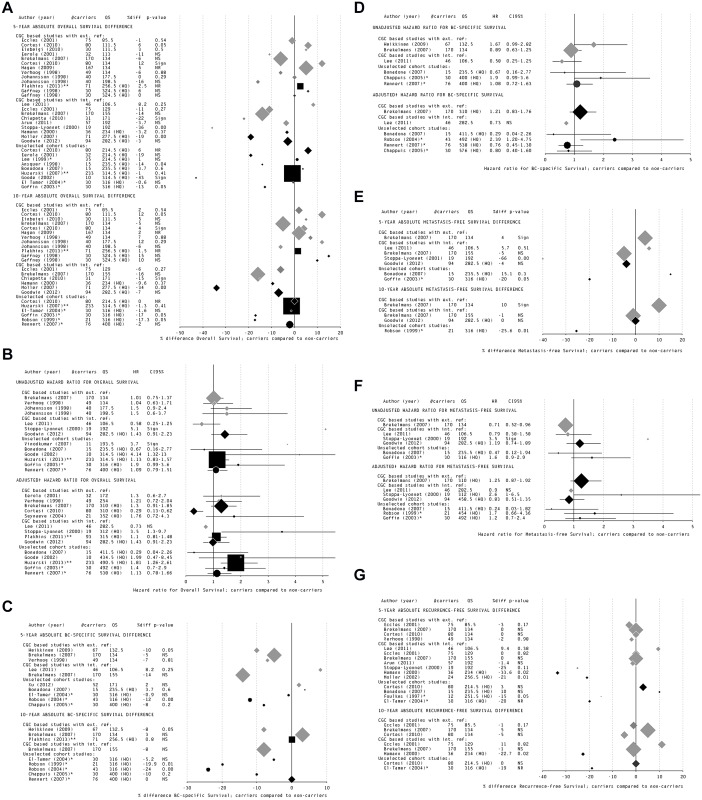
Forest plots of studies reporting survival estimates for BRCA1 mutation carriers compared to ‘non-carriers’, classified per study type and sorted by quality score.Separate forest plots are shown of studies reporting overall survival (panels A and B), breast cancer-specific survival (panels C and D), metastasis-free survival (panels E and F) and recurrence-free survival (panel G) of BRCA1 mutation carriers compared to ‘non-carriers’. Additionally, the results for each type of survival outcome are stratified per reported risk estimate: the 5-year and 10-year absolute overall survival difference (panels A, C, E, G) and the adjusted and unadjusted hazard ratios for overall survival (panels B, D, F). Size of the bullet represents the number of included carriers; black bullet = HQ study; round bullet (●) and * = A. Jewish study population, only founder mutations tested; square bullet (■) and ** = specific study population (but not A. Jewish), in which only founder mutations were tested;— = 95% Confidence interval (only for hazard ratios); CGC based studies with ext. ref. = CGC based studies with external reference group; CGC based studies with int. ref. = CGC based studies with internal reference group; Sign = statistically significant (P < 0.05); NS = not statistically significant; NR = not reported; †Adjusted for clinico-pathological characteristics and/or treatment.